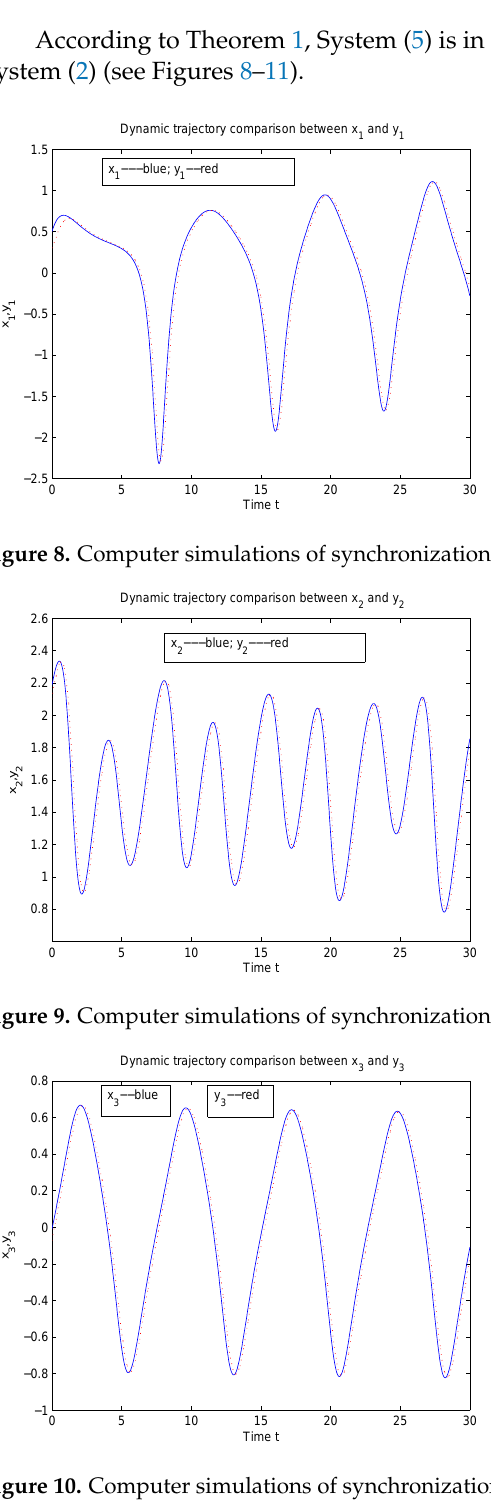
Figure 10. Computer simulations of synchronization between x 3 and y 3 for α =